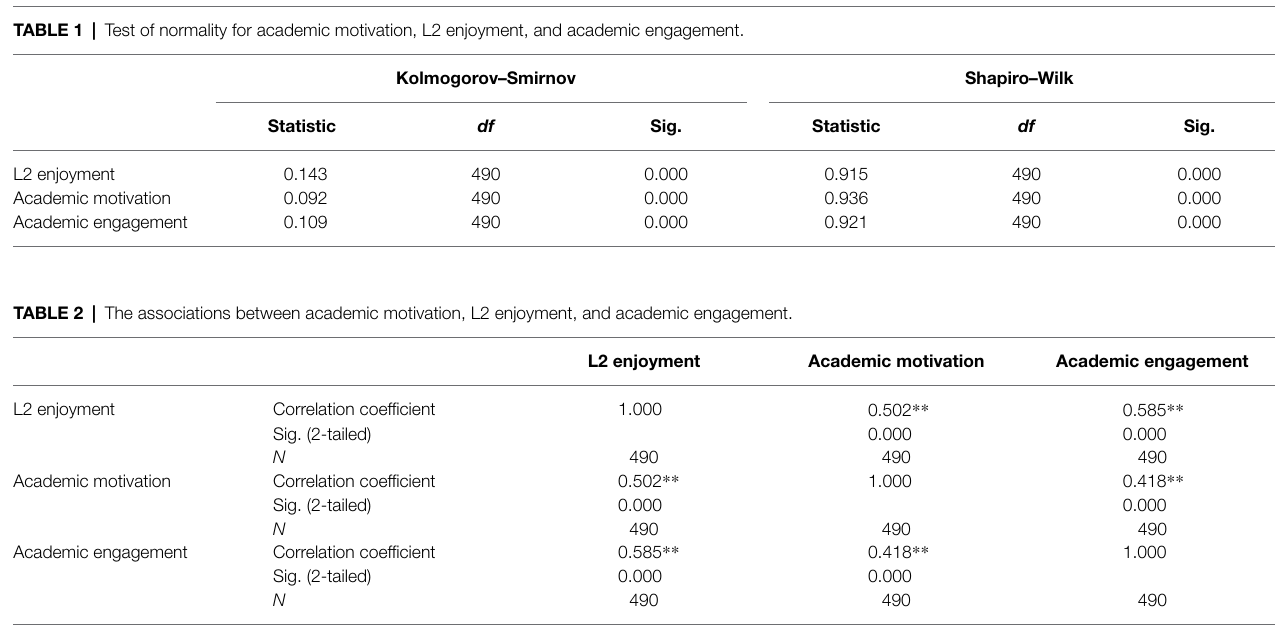
TABLE 1 | Test of normality for academic motivation, L2 enjoyment, and academic engagement. Kolmogorov–Smirnov